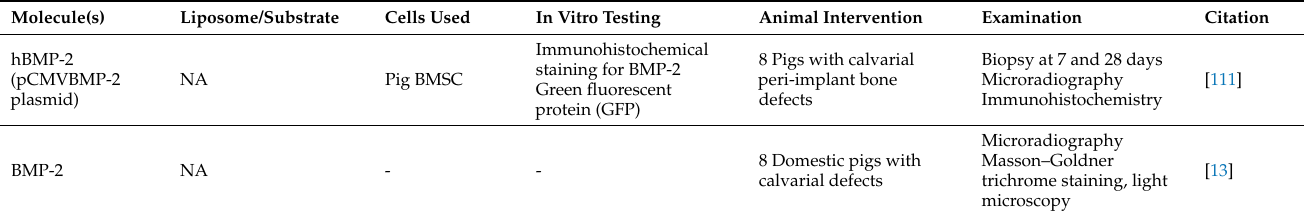
Table 2. Transfection of BMP-2